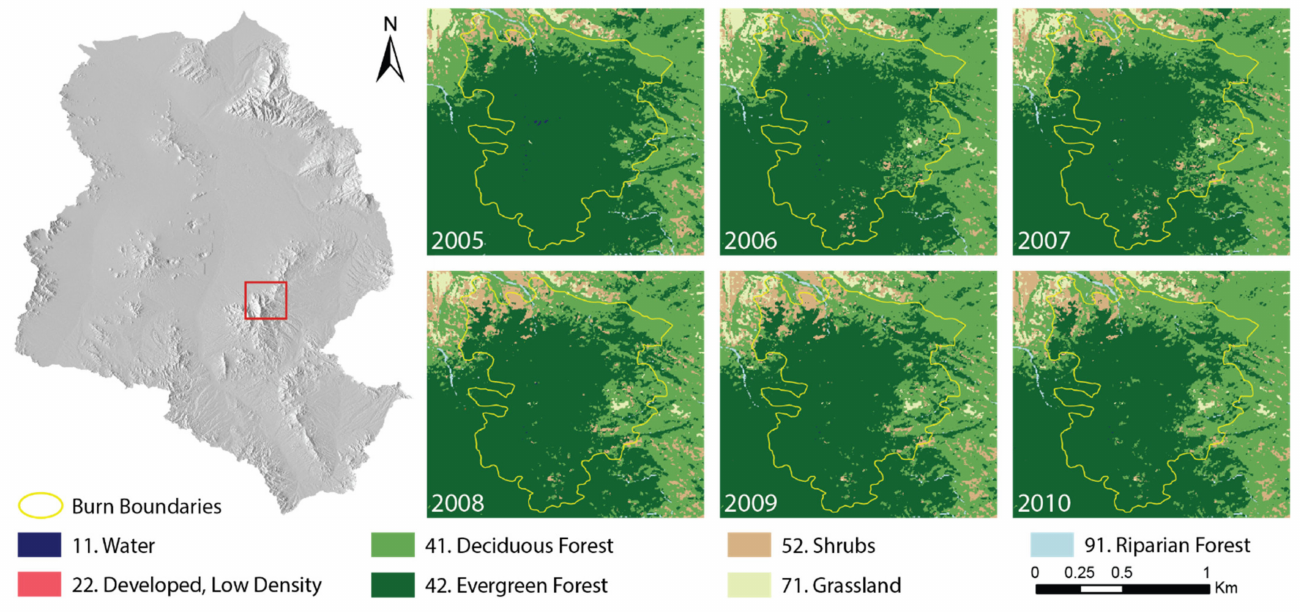
Figure 7. Monitoring sudden and gradual land cover changes following the Florida wildfire (2005) south of Tucson. Burn boundaries extracted from [83], hillshade basemap derived from